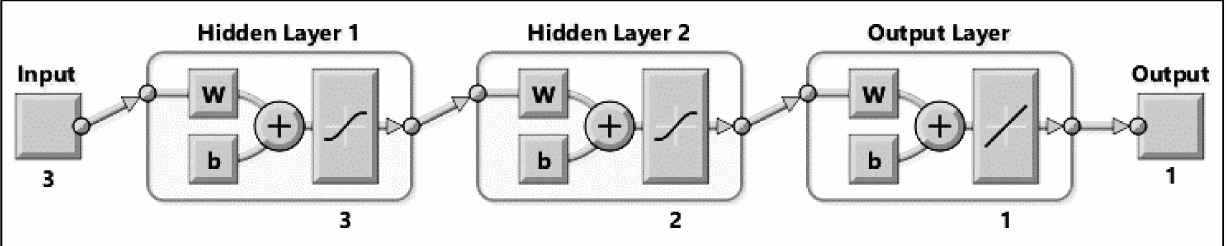
Figure 8. Overview of the Artificial Neural Network (ANN)